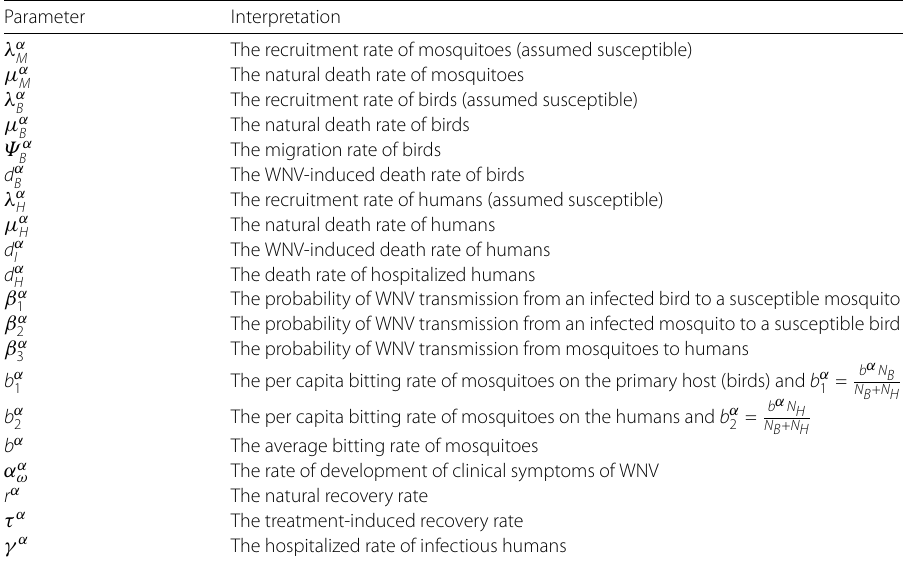
Table 2 All parameters in system (6) and their interpretation Parameter